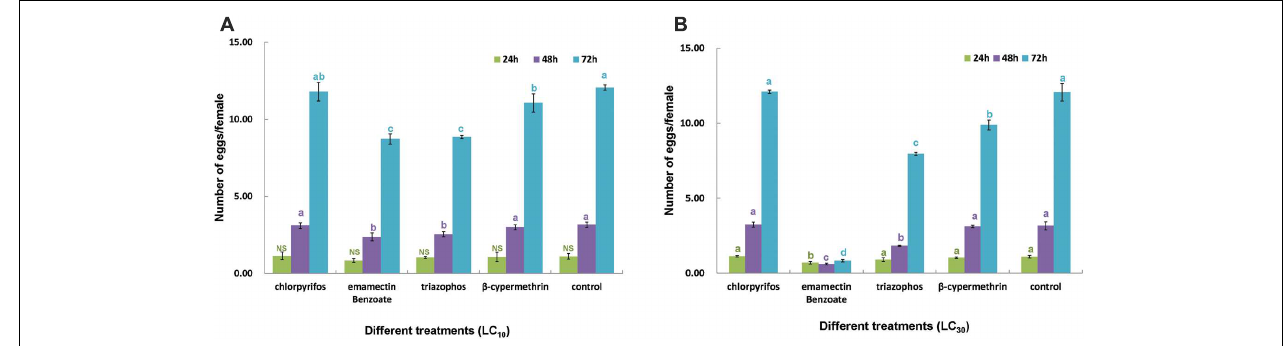
FIGURE 3 | Sublethal effect of insecticides on fecundity in C. sinensis. Four insecticides (chlorpyrifos, emamectin benzoate, triazophos, and β -cypermethrin) were used to evaluate their sublethal effects on egg-laying in C. sinensis at the concentrations of LC 10 (A) and LC 30 (B) . Daily fecundity was analyzed separately for 3 days. Data for each egg collection time were analyzed separately using one-way analysis of variance (ANOVA) with type of the insecticides as the independent variable. Then, multiple comparison procedures were performed via Tukey’s test. Different lowercase letters in different colors above the same color columns indicate significant differences at each egg collection time (24, 48, and 72 h) ( P <